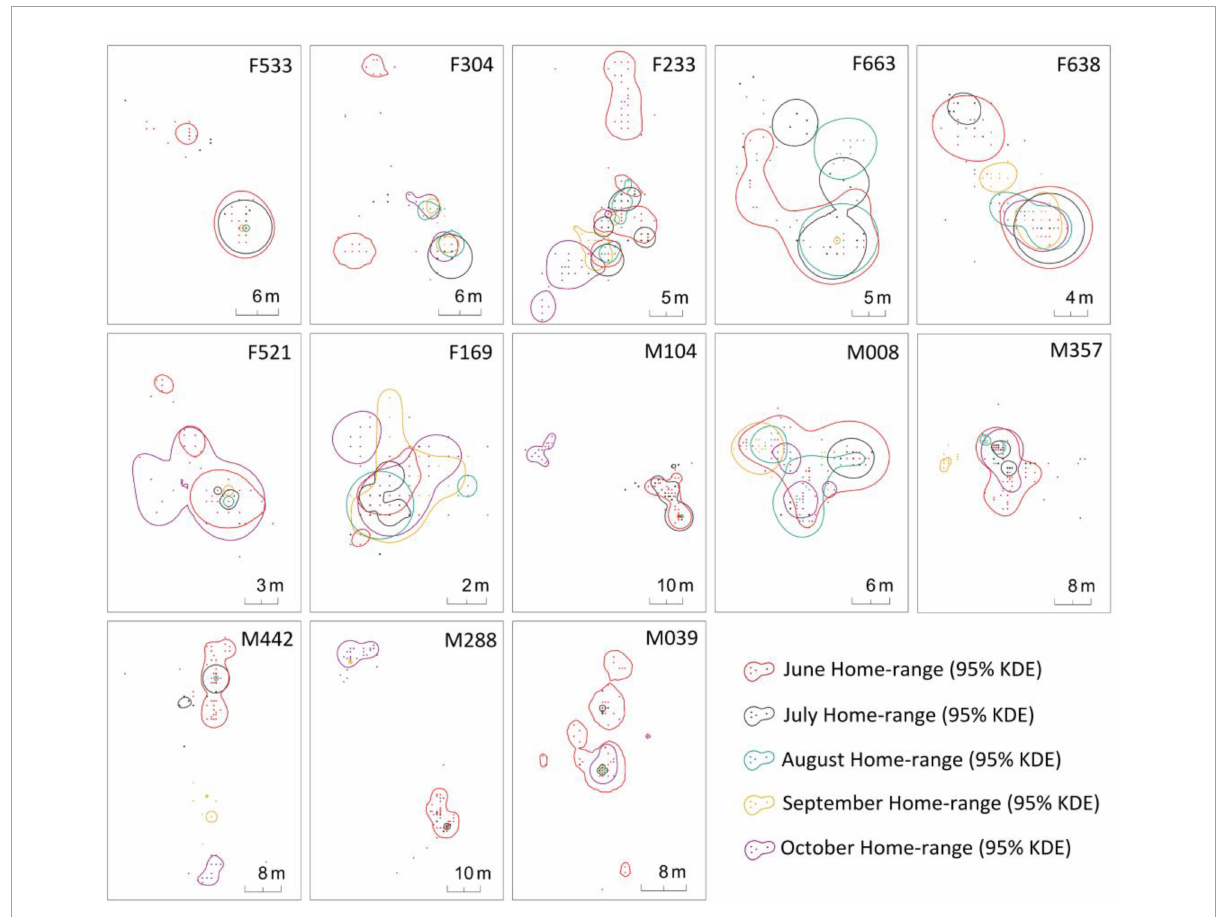
FIGURE4 Monthly dynamics of each individual home range of M. baileyi from June to October 2016.